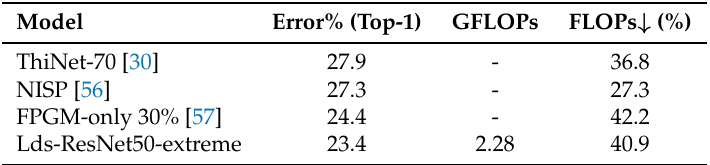
Figure 6. The extreme state of LdsConv in the ResNet. We remove the Bn and Relu layer after the 3 × 3 convolution and combine the additional convolution with the sequent 1 × 1 convolution by the matrix multiply operation. Finally the standard convolution is replaced with only depthwise convolution. The 3 × 3 LdsConv w/o AC means the depthwise part in LdsConv. The sequent 1 × 1 Conv w AC means the combing result of the additional convolution and original sequent 1 × 1 convolution. Table 4. The table shows the comparison with existing compression methods for ResNet50 on ImageNet. Our Lds-ResNet50-extreme outperforms all other methods in terms of accuracy and still has a comparable reduction on